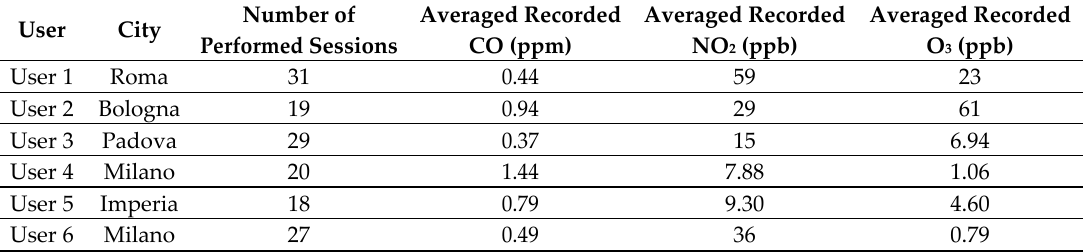
Table 1. An example of collected crowdsensing data results as preprocessed for basic exposure